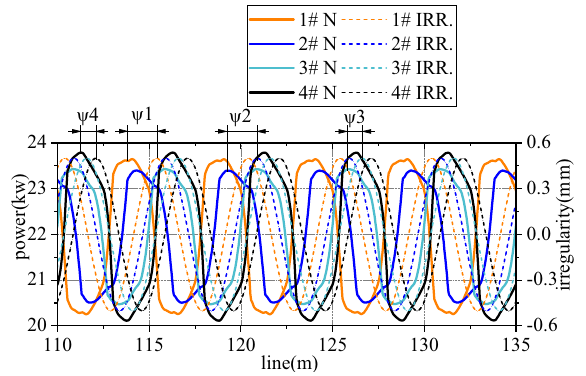
Figure 6. Position and grinding power.